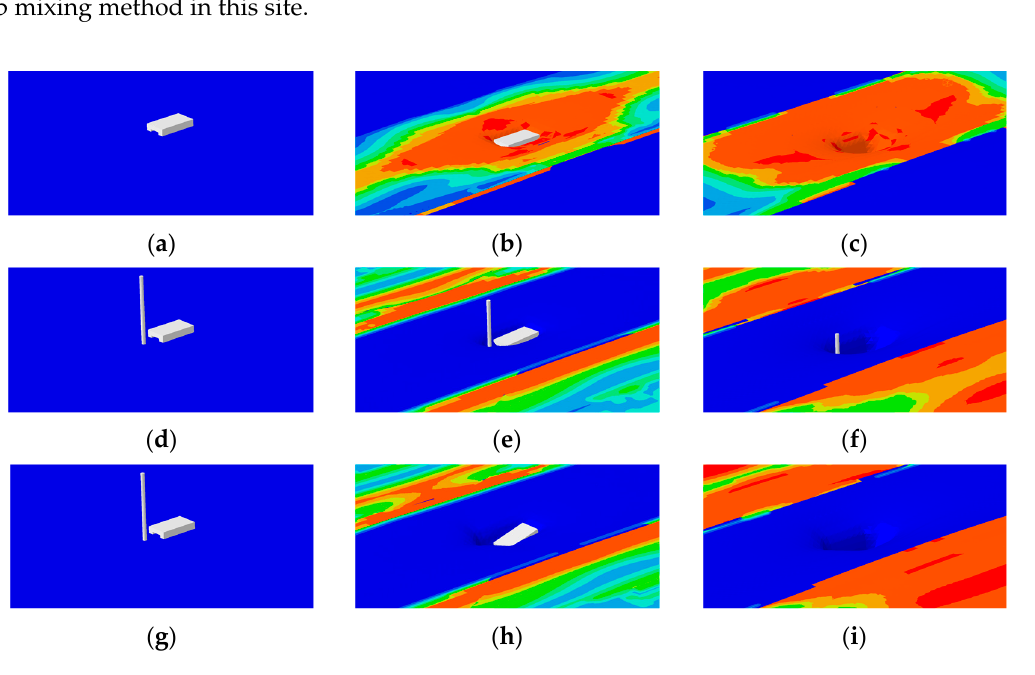
Figure 14. Results of simulating pile installation on deep mixing soil: ( a ) Self-standing of pile equipment at initial stage; ( b ) self-standing of pile equipment at medium stage; ( c ) self-standing of pile equipment at final stage; ( d ) pile jacking at initial stage; ( e ) pile jacking at medium stage; ( f ) pile jacking at final stage; ( g ) pile driving at initial stage; ( h ) pile driving at medium stage; and, ( i ) pile driving at final stage.